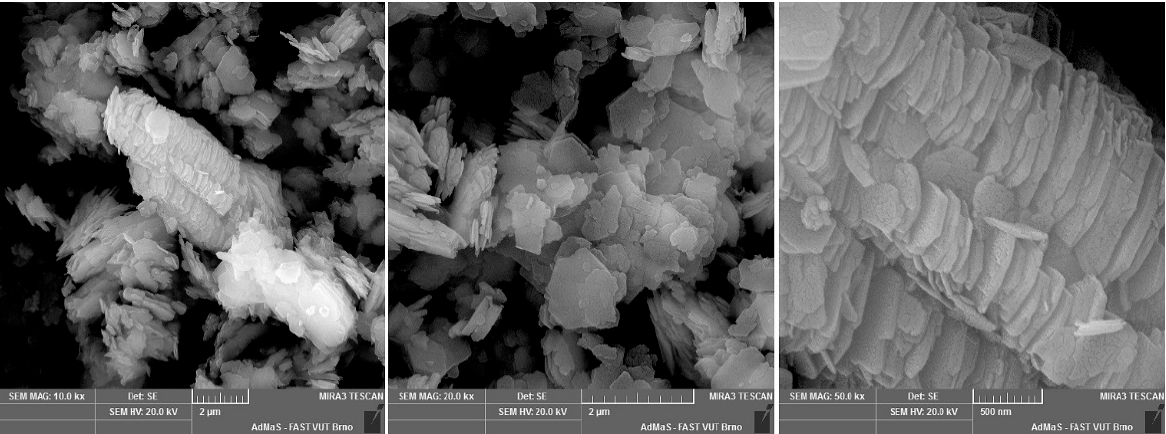
Figure A2. GP3 floated